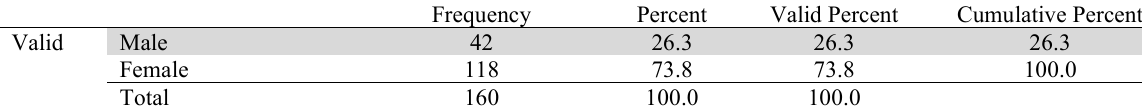
Respondents by Jobs Valid Accounting staff